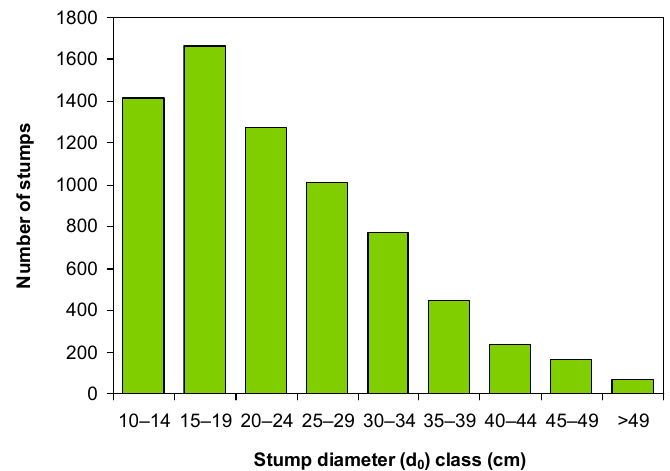
Figure 4. The frequency distribution of stumps ( n = 7042) inventoried for the final coverage data of the study.